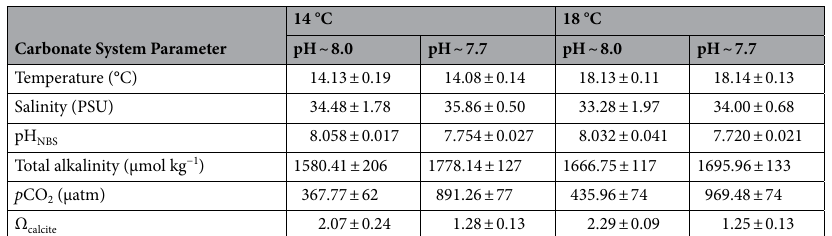
Table 1. Carbonate system parameters (mean ± SE) registered at each experimental treatment combining two nominal levels of pH (Control = 8.0 and reduced pH ~ 7.7) and temperature dominating in Tongoy Bay, Chile, during the experimental period (14 °C) and under warmer conditions (18 °C). NBS National Bureau of Standards.